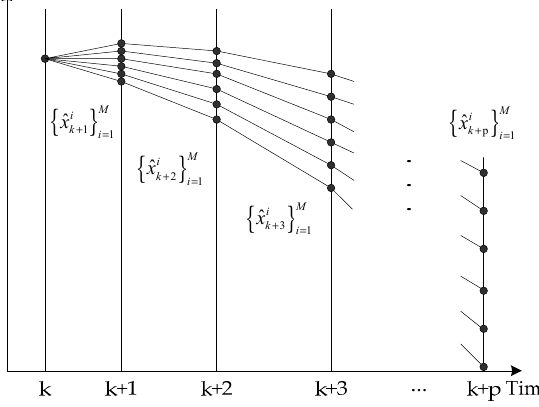
Figure 3. A schematic diagram of the disjoint principle of the degenerate trajectories. (5) Probability Distribution Approximate of Residual Life